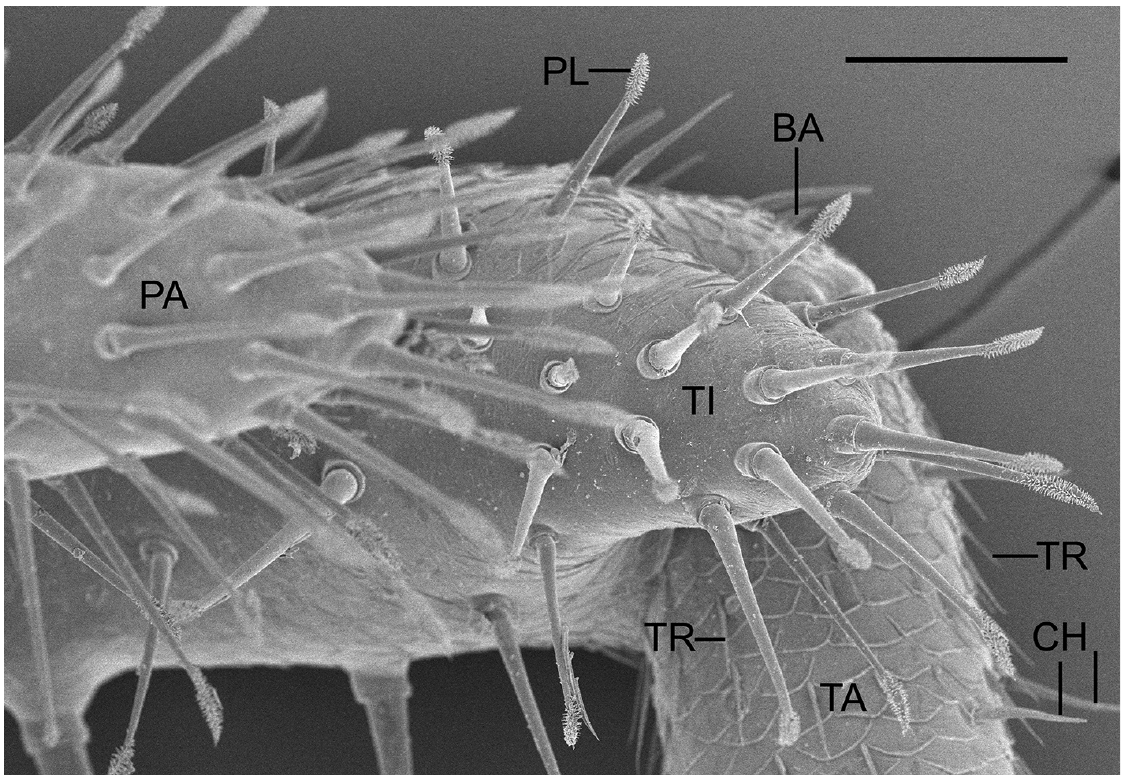
Fig. 2. Left pedipalp Dicranopalpus pyrenaeus Dresco, 1948, juvenile (CHW 490), median view, showing dense cover of plumose setae on patellar apophysis (PA) and tibia including mediodistal apophysis (TI). Abbreviations: BA = sensillum basiconicum; CH = sensillum chaeticum; PL = plumose seta; TA = tarsus; TR = trichome. Scale bar = 50 μm. SEM photo Wolff J.O. & Gorb